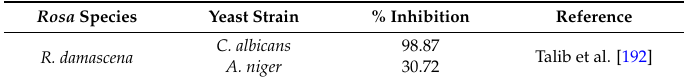
Table 8. Anti-mycotic effect of some Rosa species displayed as percentage of growth